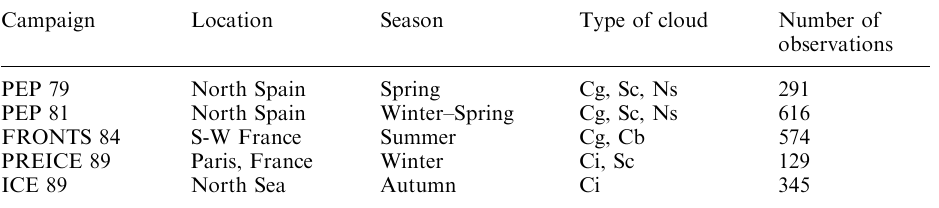
Table 1. Experiment